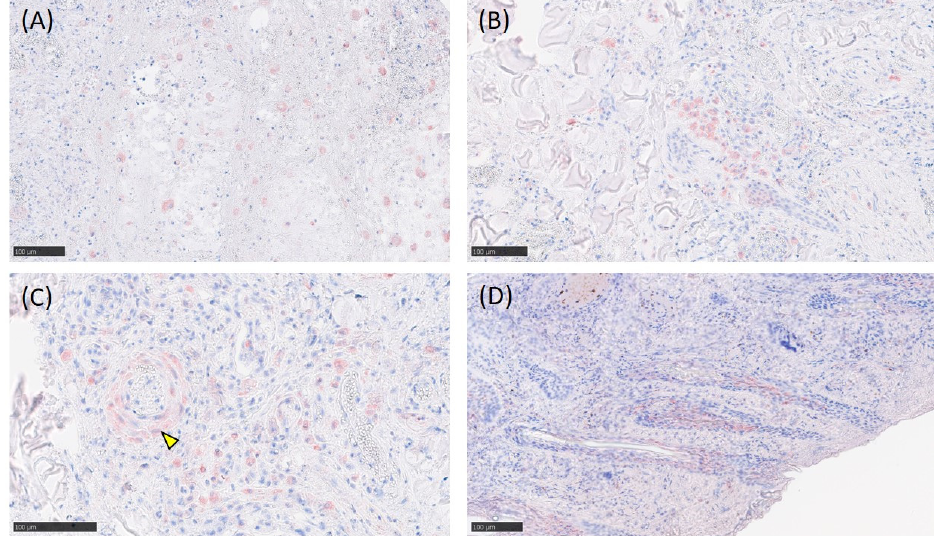
Figure 5. LSDV antigen in tissues. ( A ) Presence of LSD virus antigen in macrophages. ( B ) Hair follicle epithelial cells, endothelium, and smooth muscle cells. ( C ) Smooth muscle cells of the blood vessels (yellow arrowhead), histocytes, and macrophages. ( D ) In the hair follicle epithelium, the reaction was developed by using AEC and counterstained with hematoxylin.